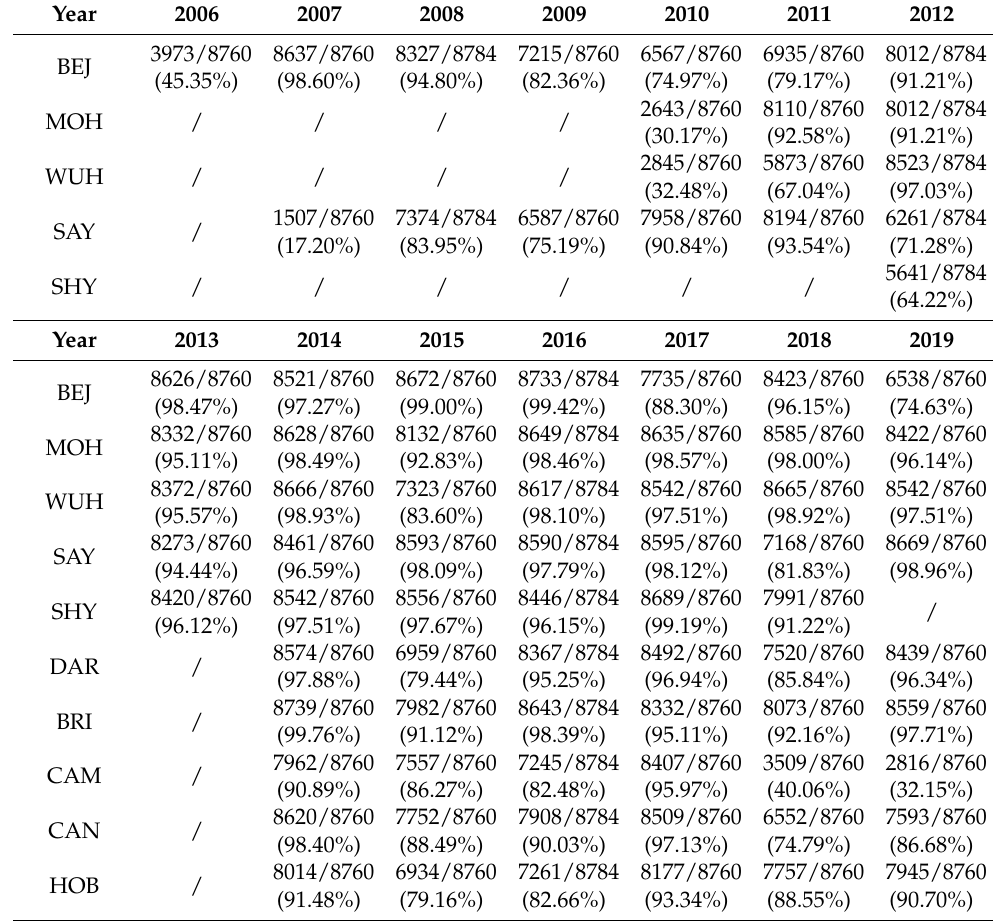
Table 2. Data availability of ionosonde stations during the period of